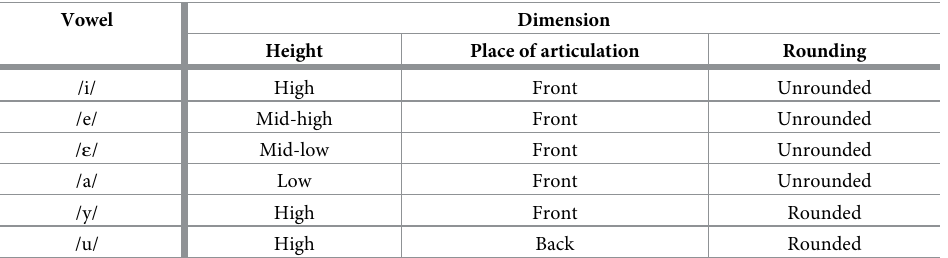
Table 1. Values for each phonetic feature of the six French oral vowels under